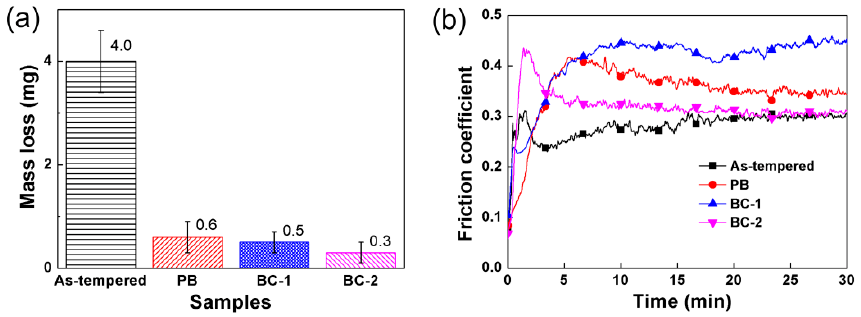
Figure 9. Mass loss and friction coefficient plotted as a function of sliding friction time for various samples.